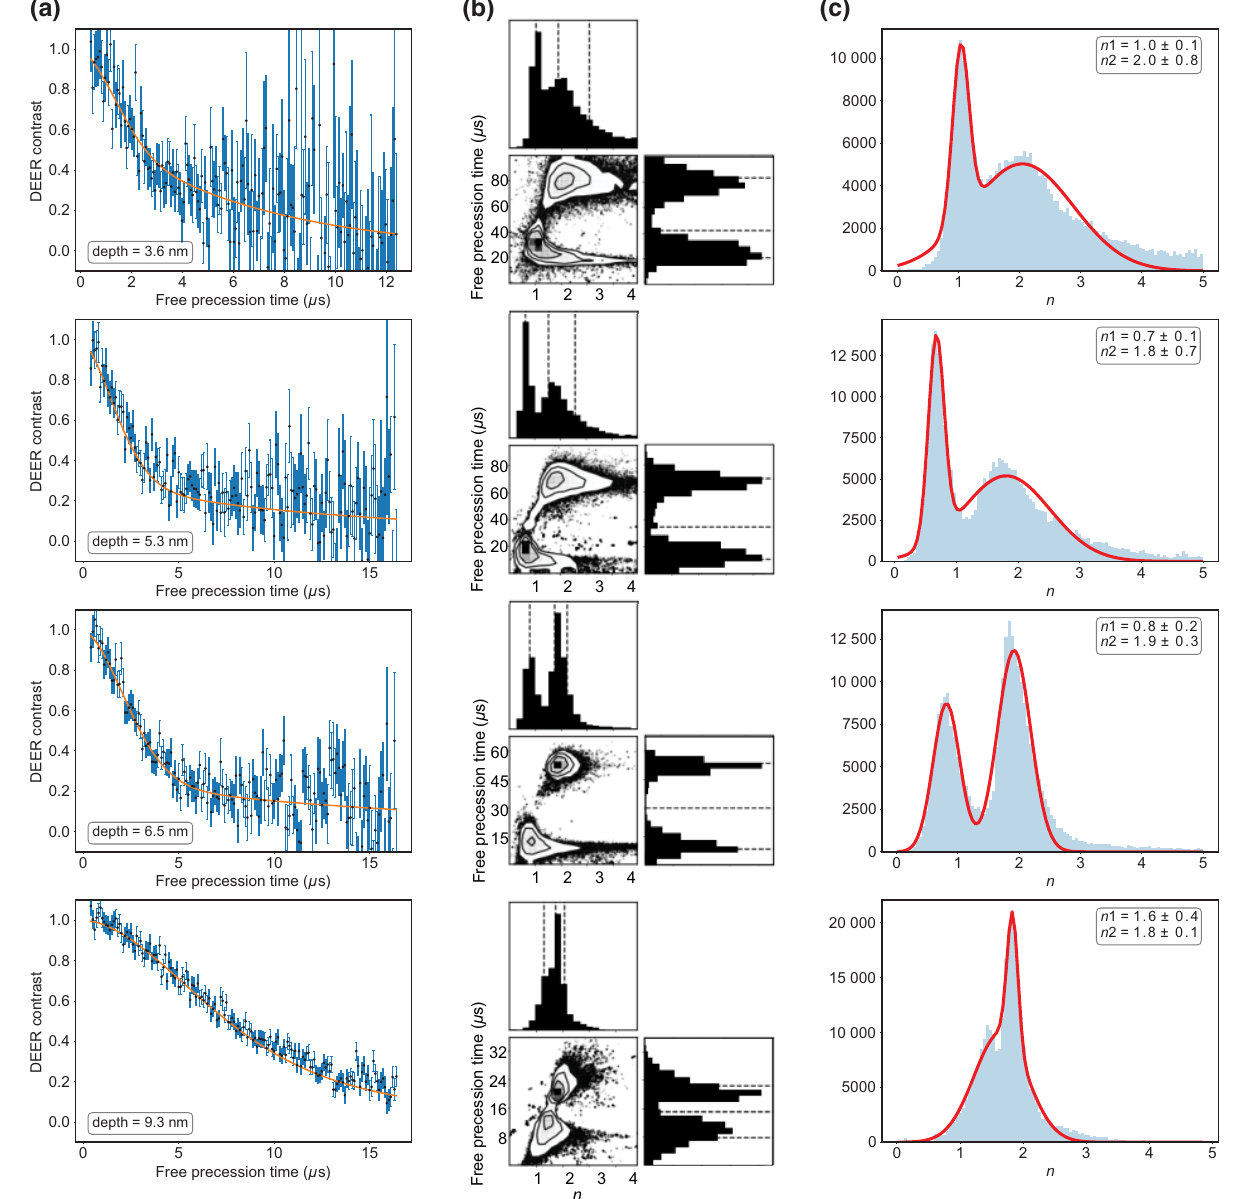
FIG. 20. Fits to a biexponential for four NV centers. (a) Data for each of the four NV centers. The orange lines are best biexponential fits based on MCMC analysis. (b) The posterior distribution function (PDF) of n versus coupling, shown for each NV. (c) The exponent stretching factors are found by fitting the PDF of n to two